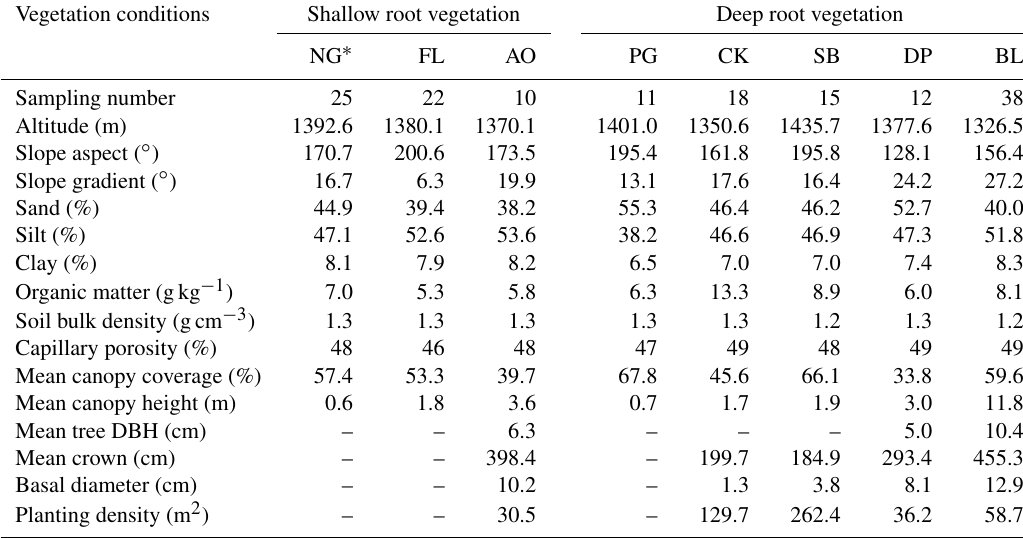
Table 2. Main characteristics and sampling numbers for different vegetation types. Vegetation